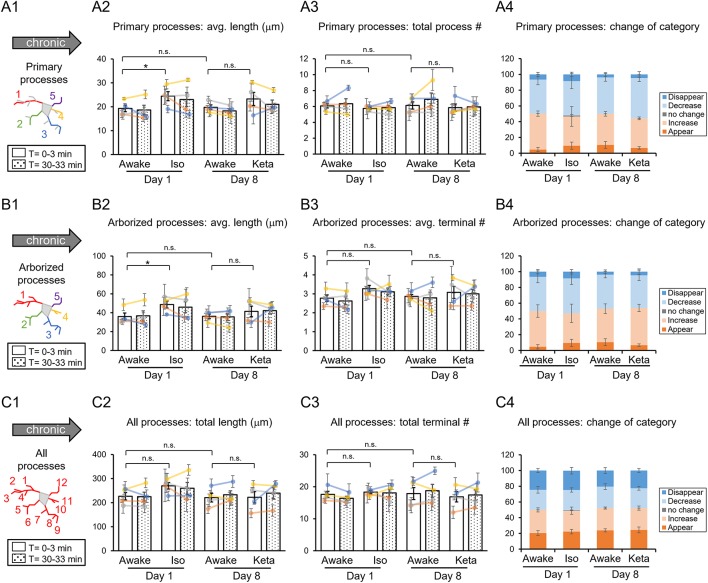
Dynamics of microglial processes in awake, isoflurane (Iso)- and ketamine (Keta)-anesthetized mice in chronic experiments (4 animals). Schematic drawings of microglial processes to be analyzed (in colors): primary processes (A1), arborized processes (B1), and all processes (C1). Quantification of average or total length and total terminal number of primary processes (A2,A3), arborized processes (B2,B3) and all processes (C2,C3). The dots show individual mean values ± SEMs per animal, the values from the same animal are connected by lines (B2,B3,C2,C3). White and dotted bars show means ± SEMs for all animals at time = 0 and 30 min. Processes are categorized according to morphological changes, such as “Disappear,” “Decrease,” “No change,” “Increase,” or “Appear” (A4,B4,C4). *p < 0.05, n.s., non-significant, one-way RM nested ANOVA, Newman-Keuls post-hoc test for A2–C2; Kruskal-Wallis test with Conover-Iman multiple comparison tests for A3–C3 and A4–C4.